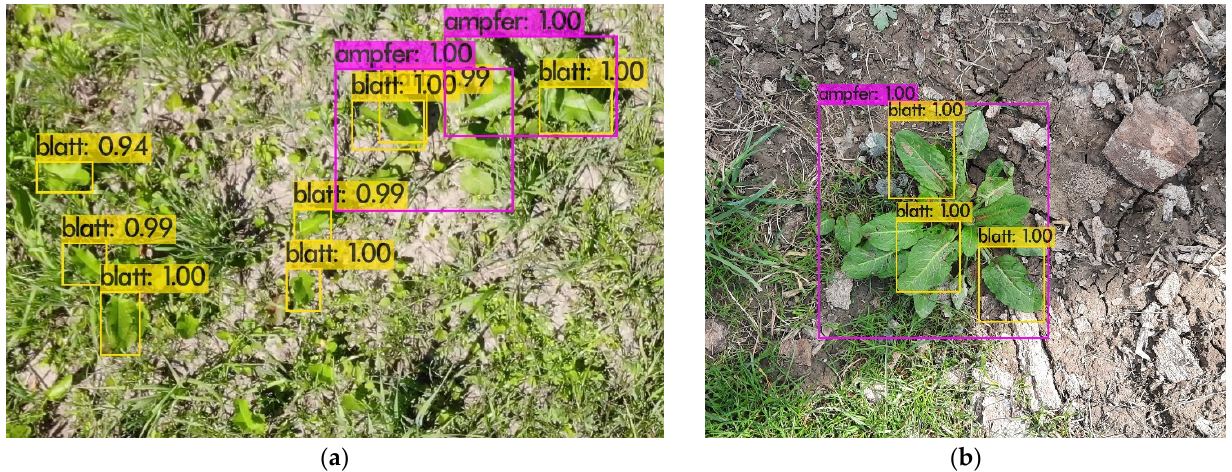
Figure 7. ( a ) Result One after Training Two; pink (plant); yellow (leaf) (germ.); ampfer = broad leaved dock (germ.); blatt = leaf; ( b ) Result Two after Training Two; pink (plant); yellow (leaf) (germ.); ampfer = broad-leaved dock (germ.); blatt = leaf.